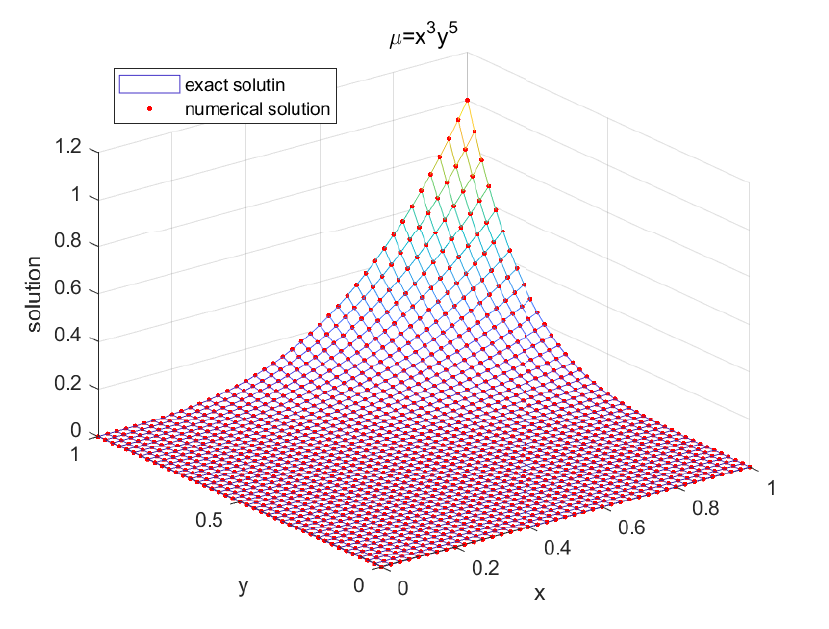
Figure 2. Comparison of numerical and exact solutions.